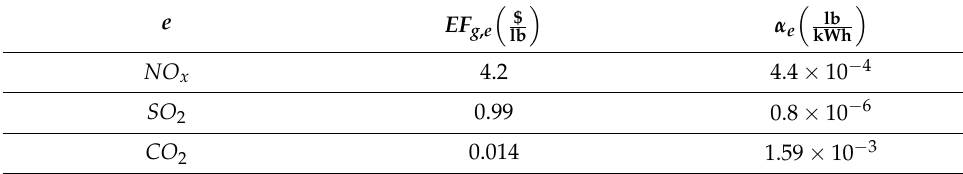
Table 5. Emission data.